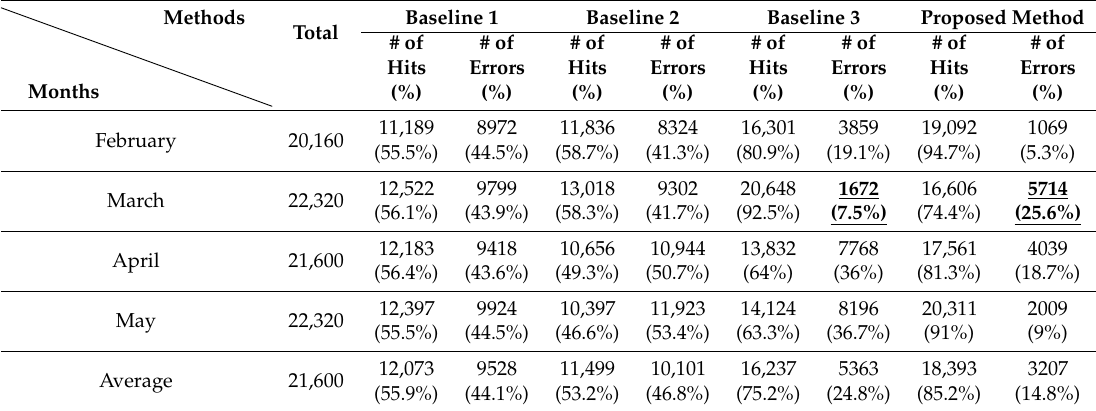
Table 3. Statistical comparison between the proposed method and three